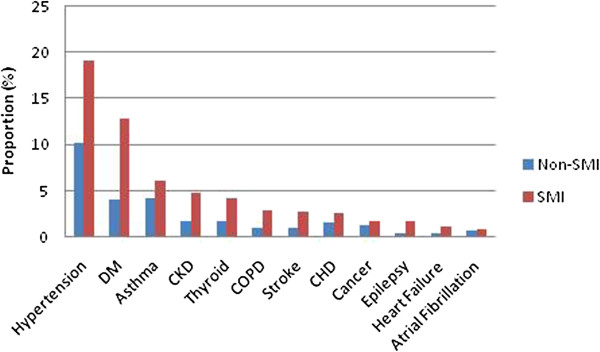
Percentage (%) of SMI and non-SMI patients recorded with each physical health condition.